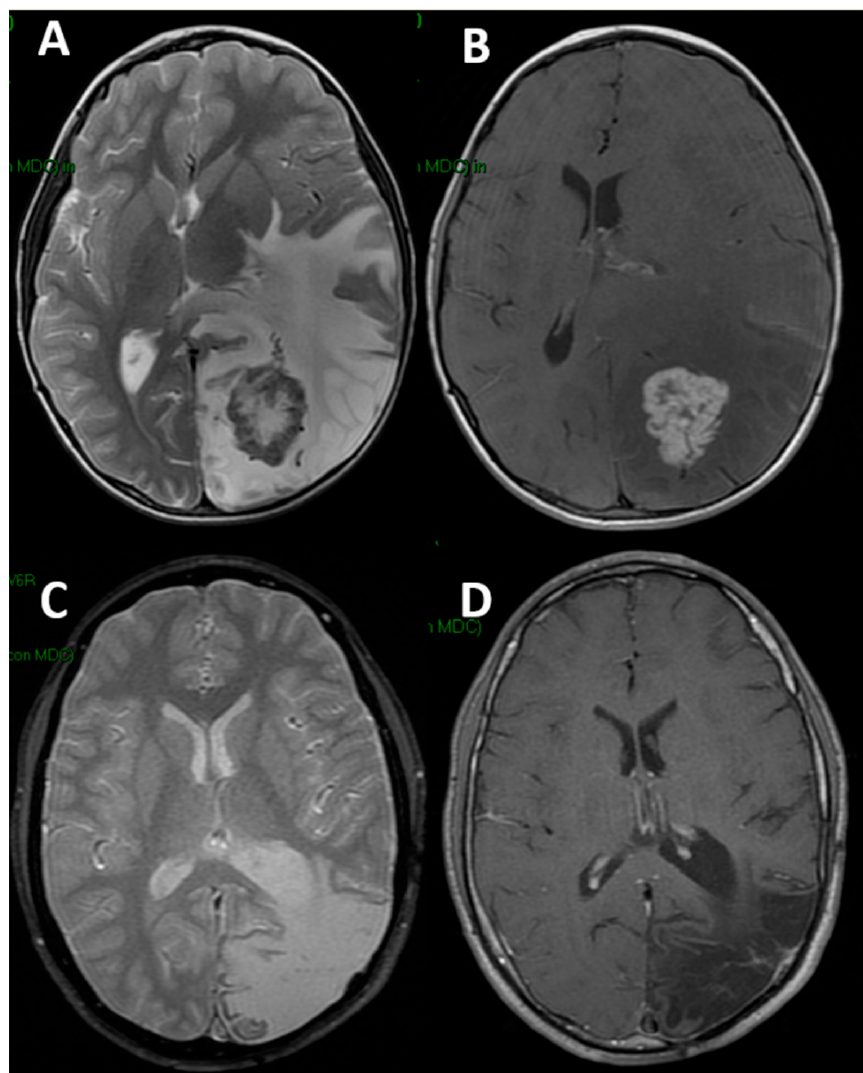
Figure 1. Preoperative brain MRI (( A ): axial T2-weighted; ( B ): axial T1-weighted after gadolinium) of a 9-year-old boy harboring an intra-axial schwannoma. Note the extensive perilesional edema and the mass effect. The same sequences ( C , D ) five years later: no tumor recurrence but glio-malacic cortical involution is present. The patient is relying on ASMs and vagal nerve stimulation. In Group 2, early seizures (5/10 cases) were prevalent with late (3/10) and immediate seizures (2/10) being less prevalent (Table 2). Purely focal seizures occurred in 2 out of 10 cases, the remaining patients showed primary or secondary generalized seizures (7 children had hyponatremia). Mainly, multiple seizures were evident (6 cases, 5 of them requiring transient ASMs). Three children (3.2%) ultimately developed epilepsy (focal to generalized tonic–clonic, generalized tonic–clonic, and absence in one each), at a mean of 3.5 months after surgery. Two of them (one with optic–hypothalamic astrocytoma and one with craniopharyngioma) had the postoperative course complicated by electrolytic imbalance with hyponatremia due to SIADH. The remaining patient (a young boy with tentorial atypical meningioma) developed postoperative occipital subcortical glio-malacic degeneration. At late follow-up, all of them are seizure-free; two of them still receive ASMs, while the treatment has been discontinued in the boy with craniopharyngioma (Figure 2). The remaining patients are seizure-free and